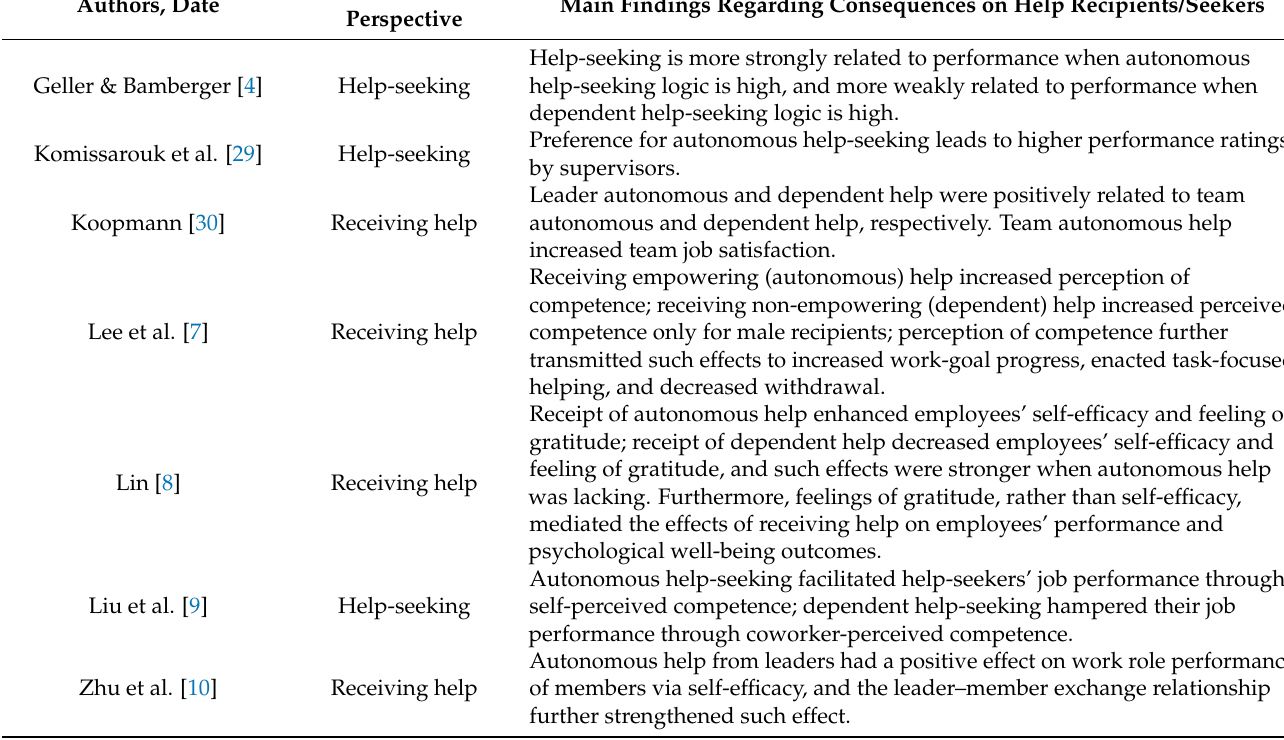
Table 1. A Summary of Research on Workplace Autonomous and Dependent